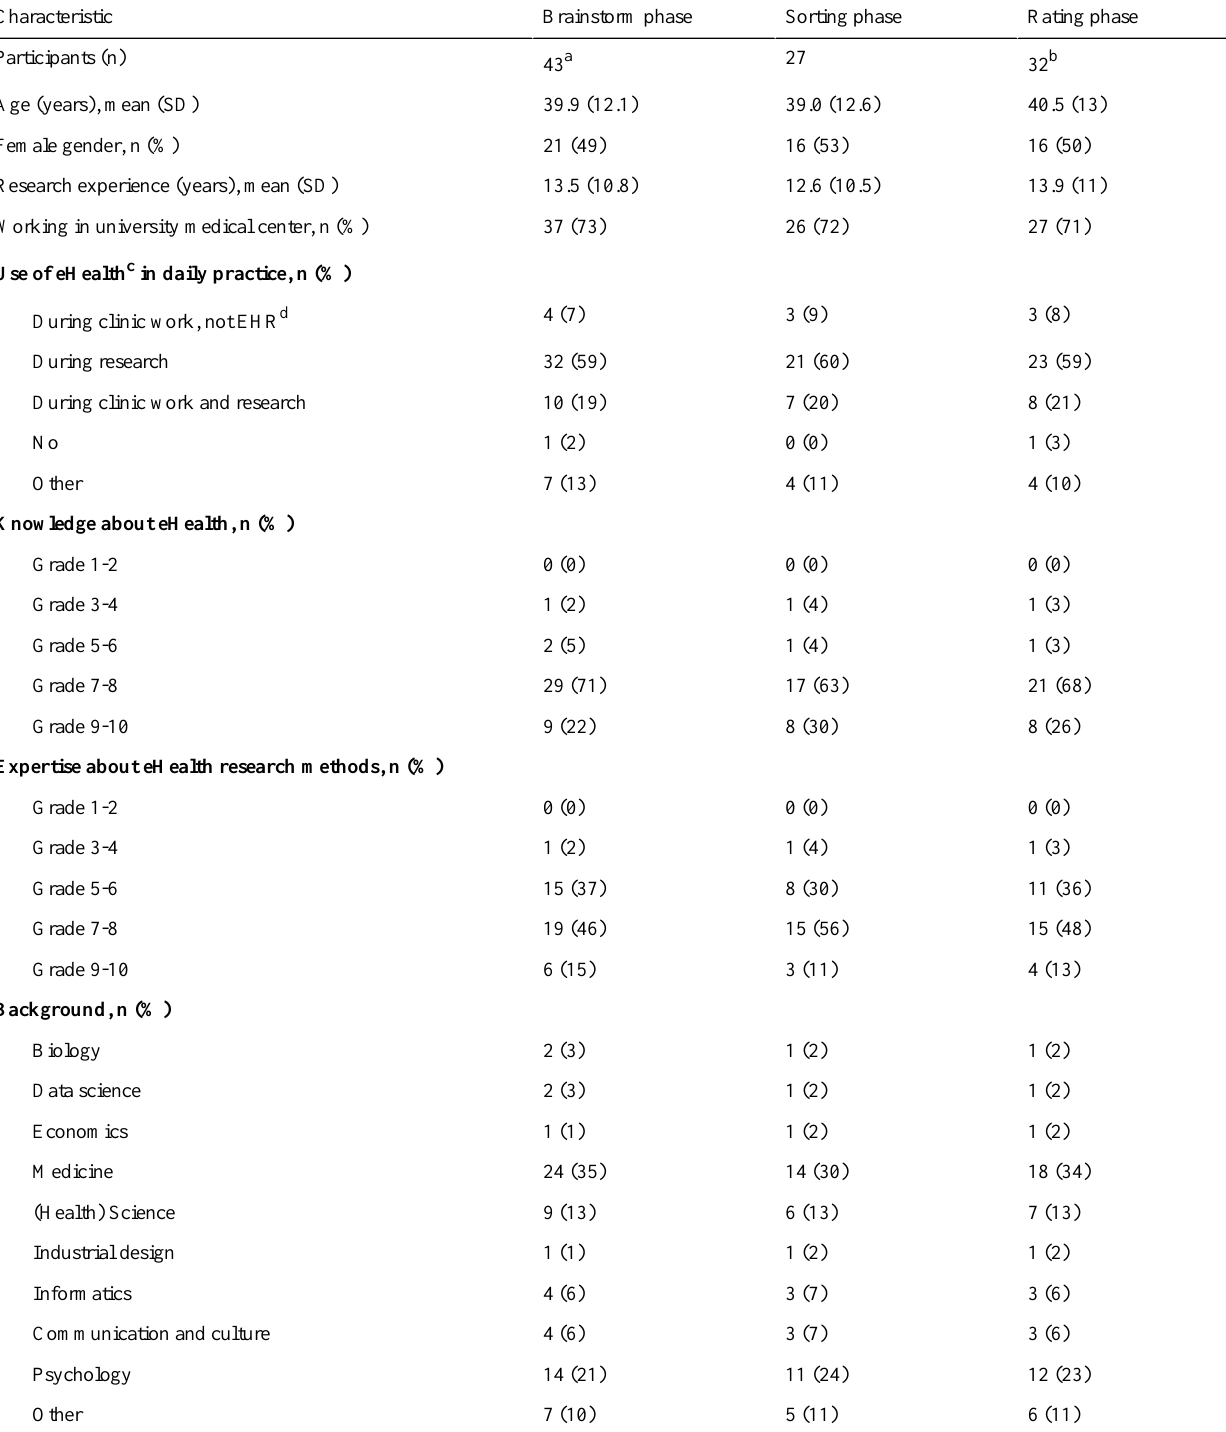
Table 2. Characteristics of study participants for each phase of the concept mapping study.